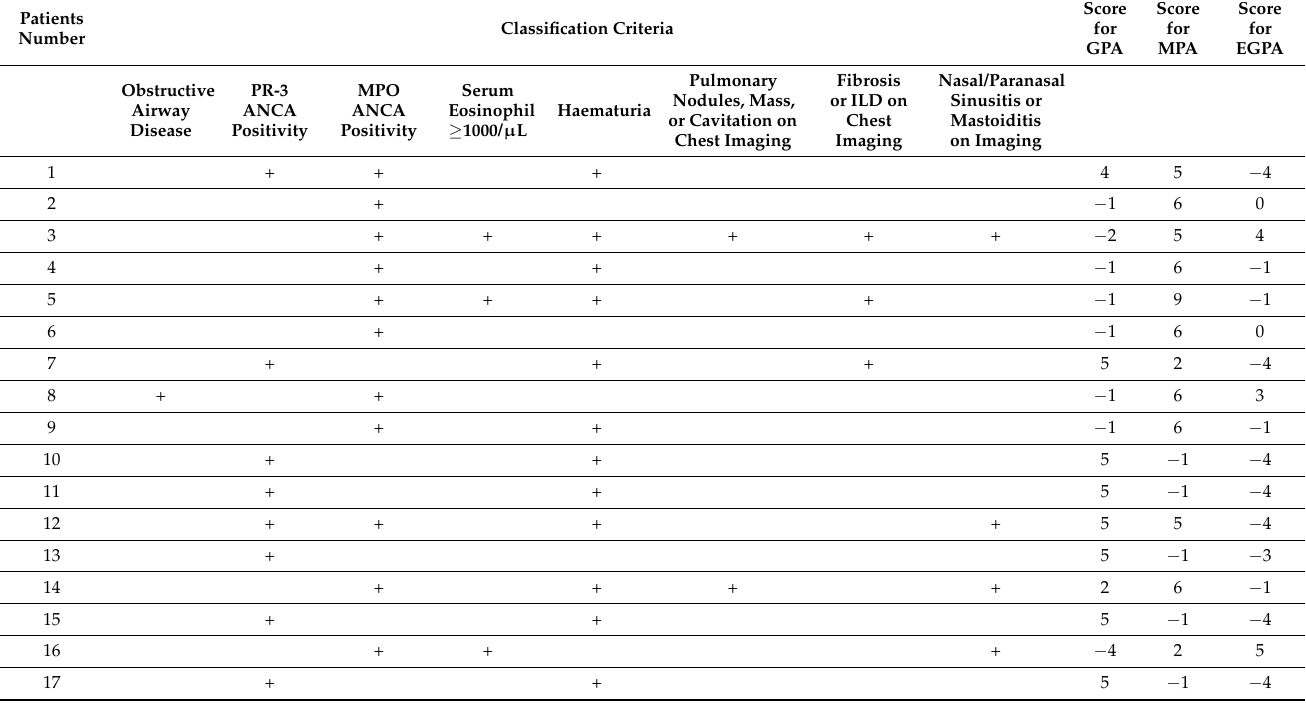
Score Score for for GPA